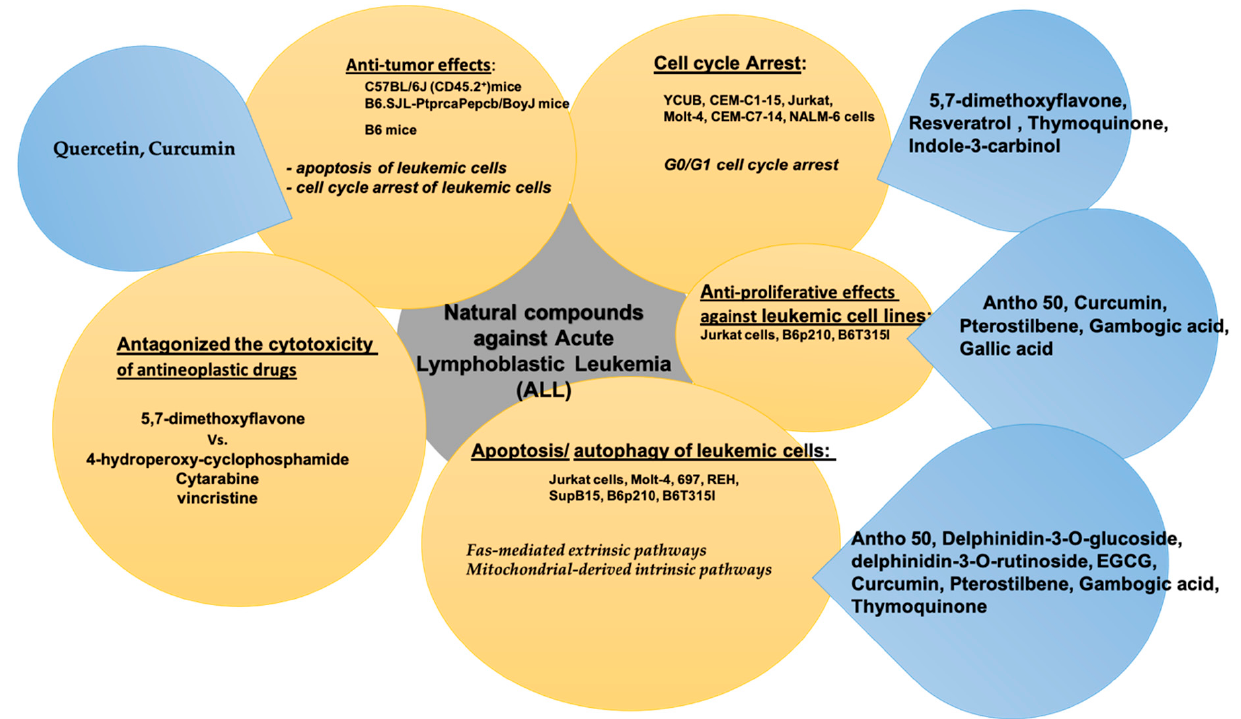
Figure 3. Natural compounds against acute lymphoblastic leukemia (ALL).